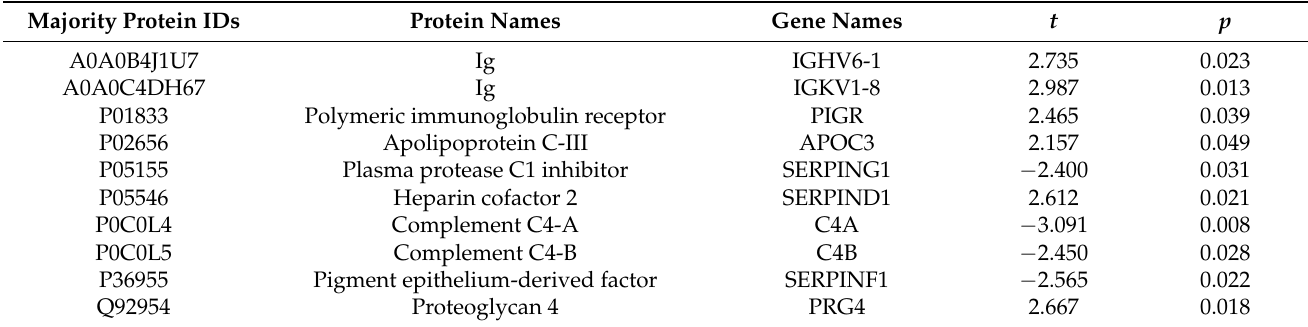
Table 4. Differential proteins in simple gout group and gout with renal injury